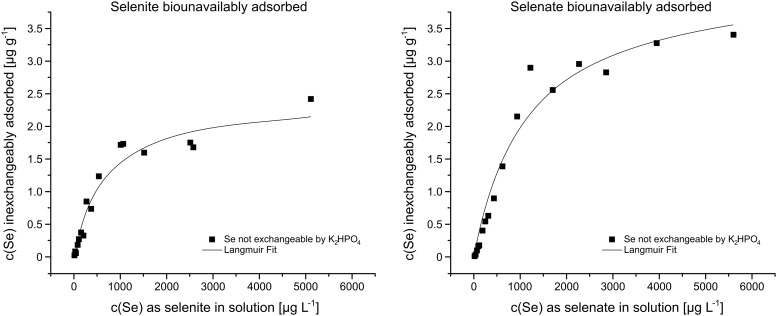
Selenite and selenate adsorption which was inexchangeable by K2HPO4 was considered biounavailable.